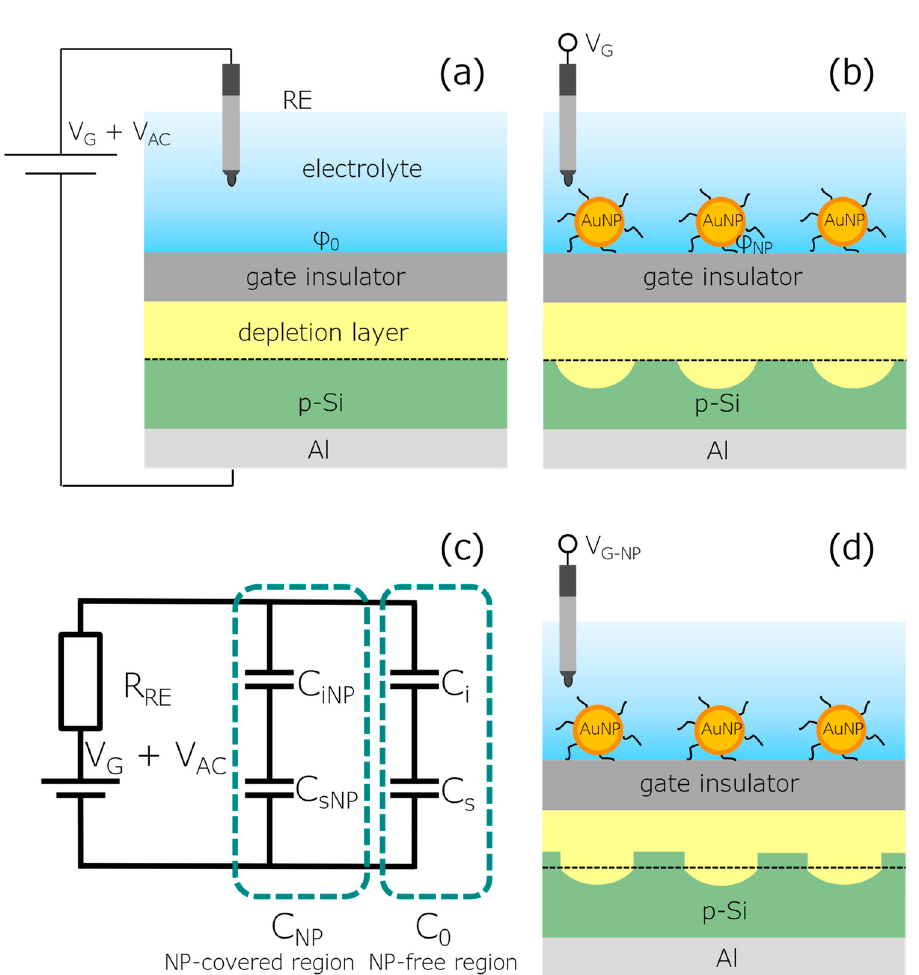
Figure 1. Schematic structure and shape of the depletion layer in p-Si for a bare EISCAP ( a ) and an EISCAP decorated with ligand-stabilized positively charged AuNPs ( b ); ( c ) electrical equivalent circuit of an AuNP-decorated EISCAP; and ( d ) local changes in the width of the depletion layer at the gate voltage ( V G-NP ), which is applied to the AuNP-decorated EISCAP in the ConCap mode to keep the working capacitance constant. R RE : resistance of the reference electrode; V G : gate voltage; V AC : alternating current voltage; C iNP , C sNP and C NP : gate-insulator, space-charge and total capacitances in an AuNP-covered region, respectively; C i , C s and C 0 are the corresponding parameters for AuNP-free regions; φ 0 and φ NP : gate insulator-electrolyte interfacial potential in the AuNP-free and AuNP-covered regions.